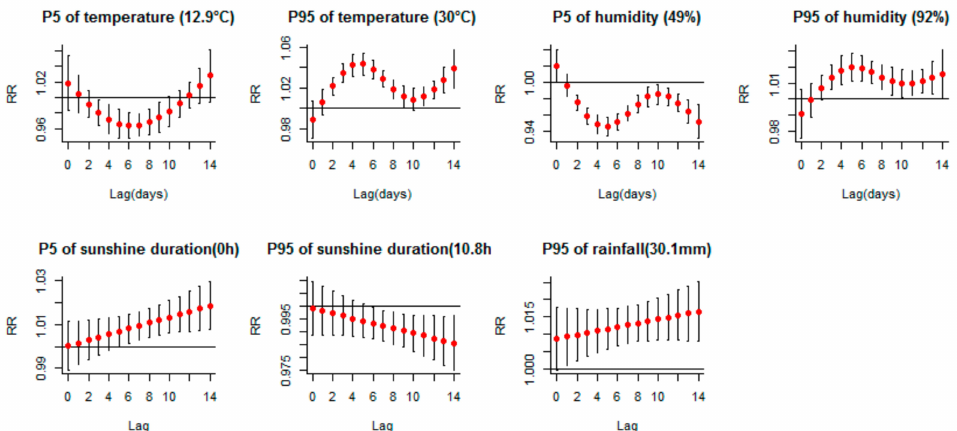
Figure 3. Lag-response curves for P5, P95 of meteorological variables on HFMD occurrence (5th percentile of rainfall was 0 mm, the same with the reference value, so the e ff ect of 5th percentile of rainfall was not shown). The red points are the relative risks (medians as references), and the black bars are 95% CIs. Shenzhen